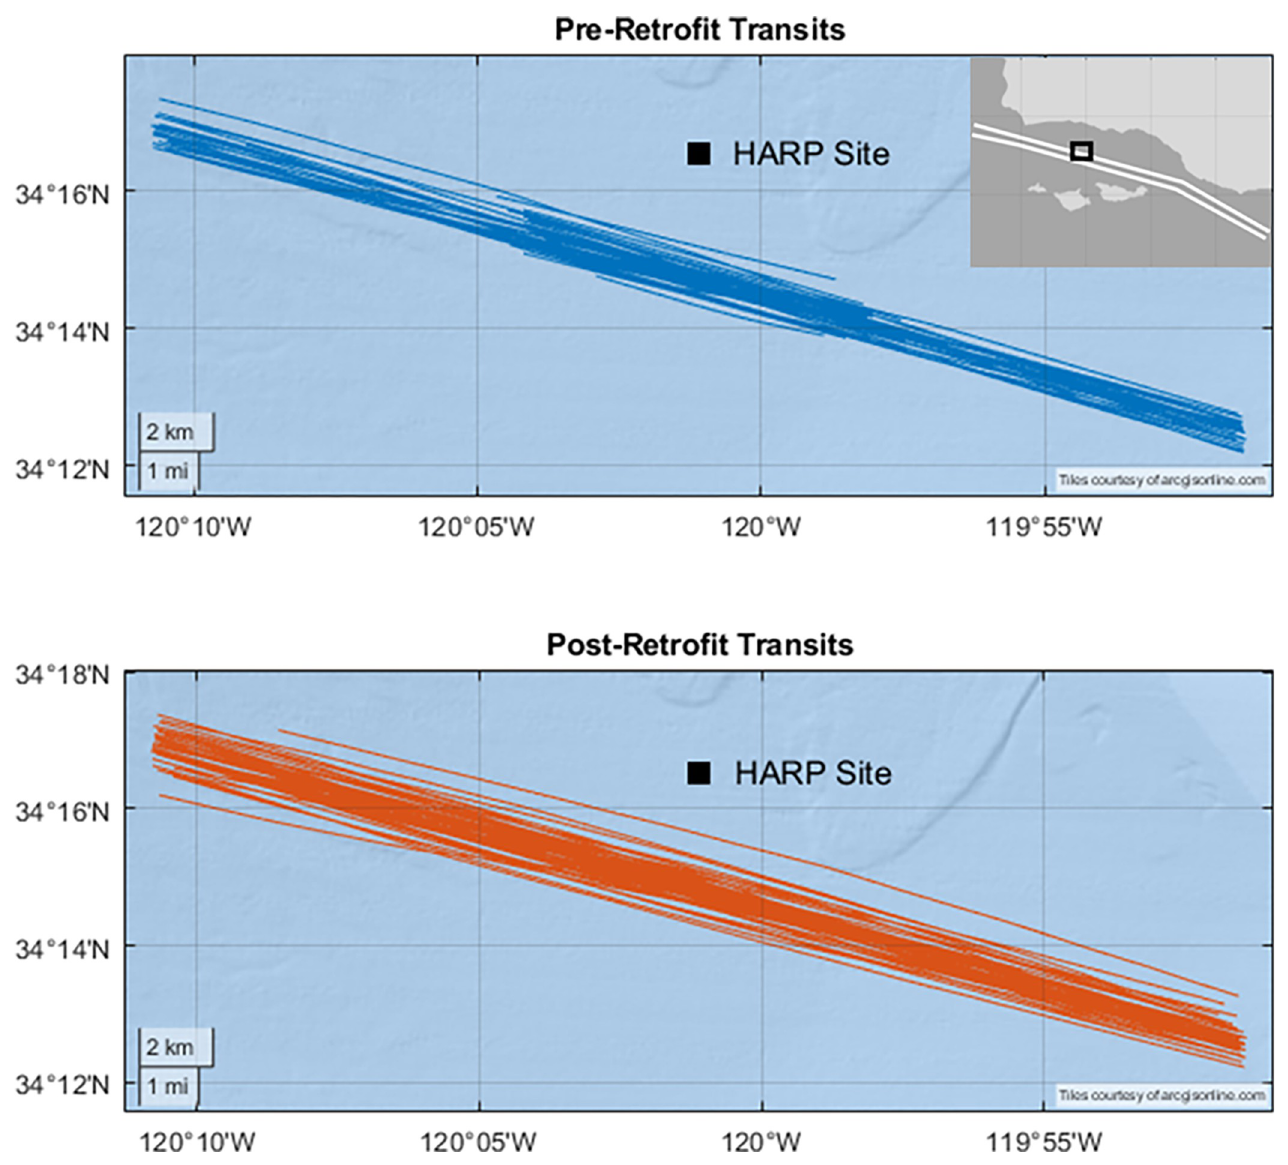
Fig 2. Study site in the Santa Barbara Channel. Top: Pre-retrofit transits are shown in blue. Bottom: Post-retrofit transits are shown in red. The location of the High-frequency Acoustic Recording Package (HARP) is labeled with a square. The inset map in the upper right corner shows the north-south Traffic Separation Scheme as white